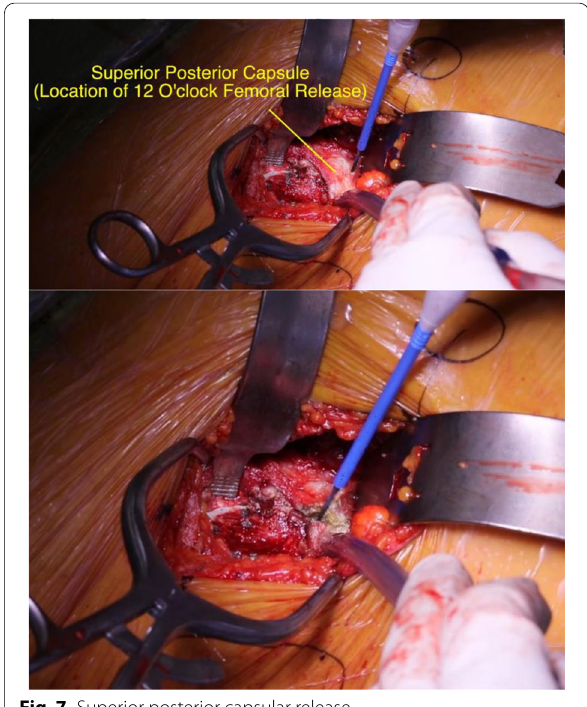
Fig. 7 Superior posterior capsular